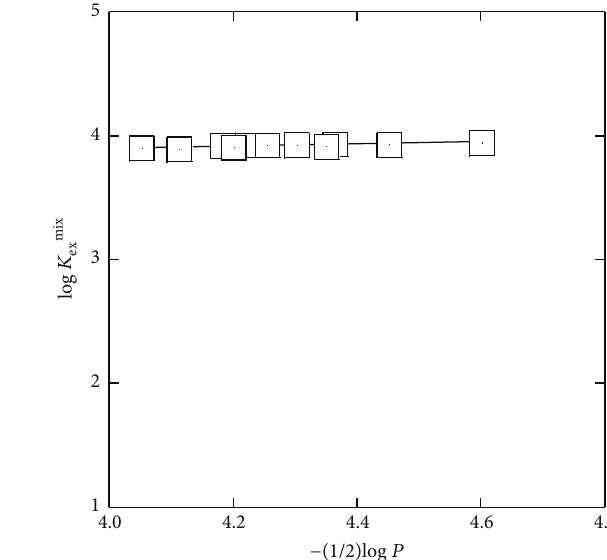
and 𝐾 values were obtained ex ± ex